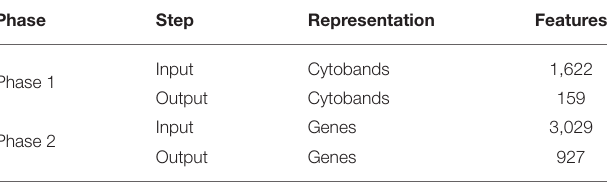
TABLE 2 | The number of features before and after each extraction phase.